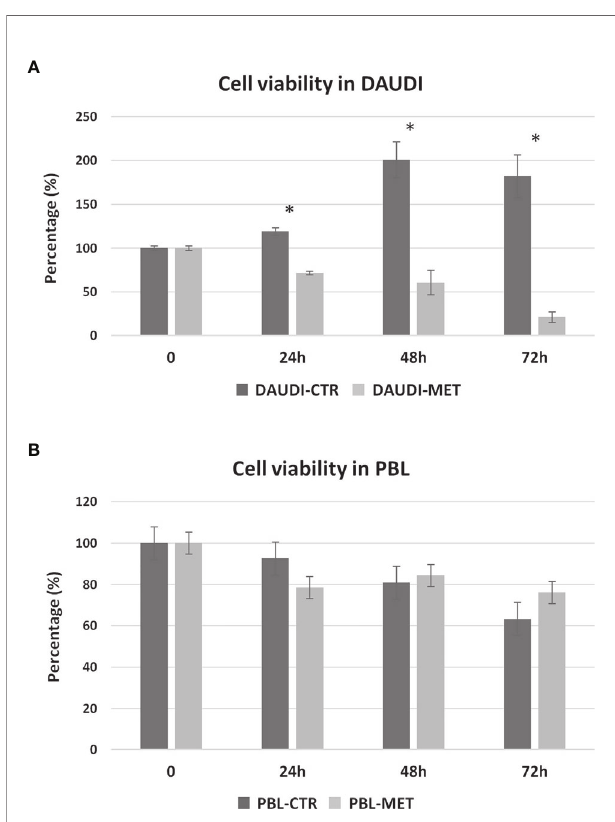
FIGURE 5 | Metformin effect on cell viability. DAUDI cells (A) and PBL (B) were treated with 10 mM metformin for 24, 48 and 72 hours. CTR, untreated cells; MET, treated cells with 10mM Metformin. Signi fi cance is expressed by comparing treated cells versus the respective untreated ones (Wilcoxon signed rank test; *two-tailed p-values ≤